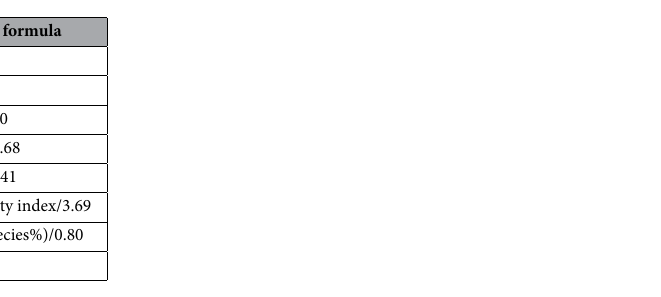
Table 4. Core metrics and calculation formulas.